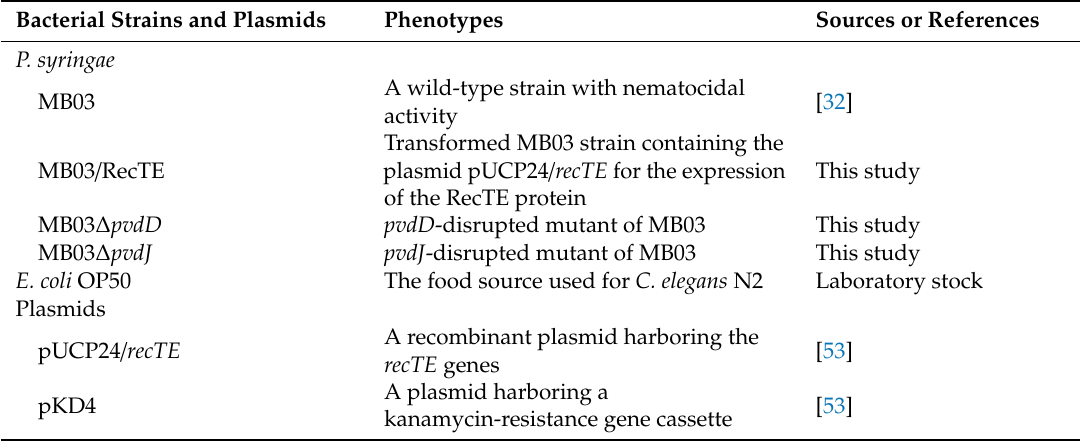
Table 1. Bacterial strains and plasmids used in this